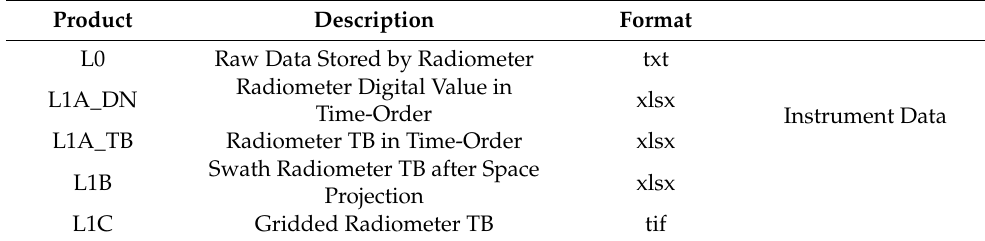
Table 3. Naming and description of data products.